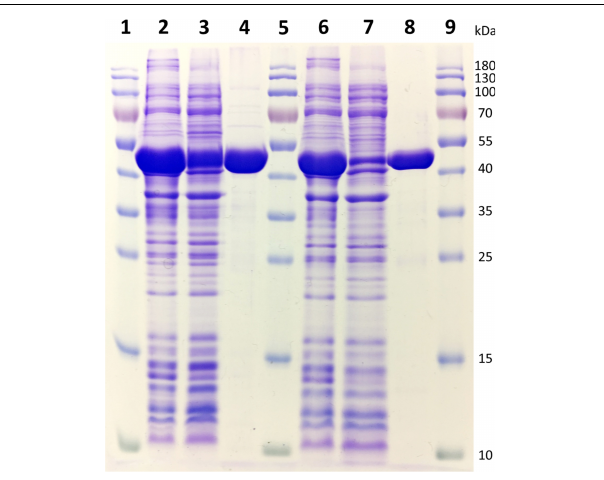
FIGURE 5 | 12% SDS–PAGE gel representing the purification of recombinant Vcz and URA3 deaminases. 1, 5, and 9: PageRuler TM Prestained Protein Ladder (Thermo Fisher Scientific); 2: total proteins obtained from induced E. coli BL21(DE-3) bacteria transformed with pET28a-Vcz; 3: soluble protein fraction of E. coli BL21(DE-3) bacteria transformed with pET28a-Vcz; 4: ∼ 40 µ g of recombinant 6xHis-tagged Vcz deaminase; 6: total proteins obtained from induced E. coli BL21(DE-3) bacteria transformed with pET21b-URA3; 7: soluble protein fraction of E. coli BL21(DE-3) bacteria transformed with pET21b-URA3; 4: ∼ 30 µ g of recombinant 6xHis-tagged URA3